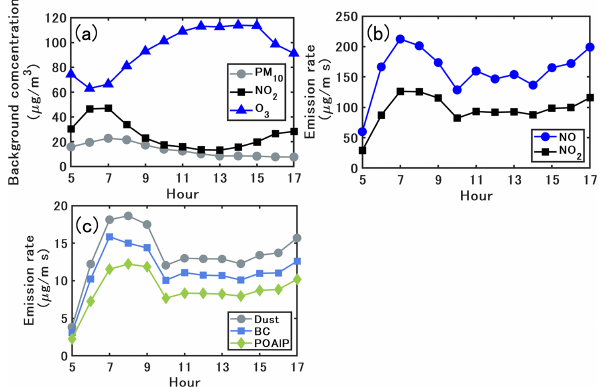
Figure 3. Time variations of (a) PM 10 , NO and NO 2 background concentrations, (b) emission rates of NO and NO 2 and (c) emission rates of dust, BC, and organics